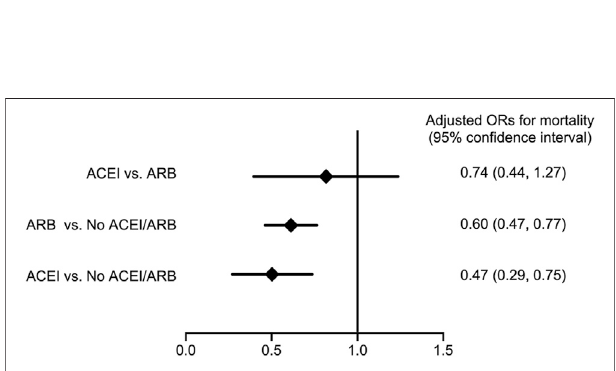
FIGURE 3 | Forest plot depicts the adjusted odd ratios for long-term all- cause mortality following major surgery with comparison between various conditions of ACEI or ARB usage. Abbreviations: ACEI: angiotensin- converting-enzyme inhibitor; ARB: angiotensin receptor blocker; No ACEI/ARB: No ACEI or ARB use within 90 days before